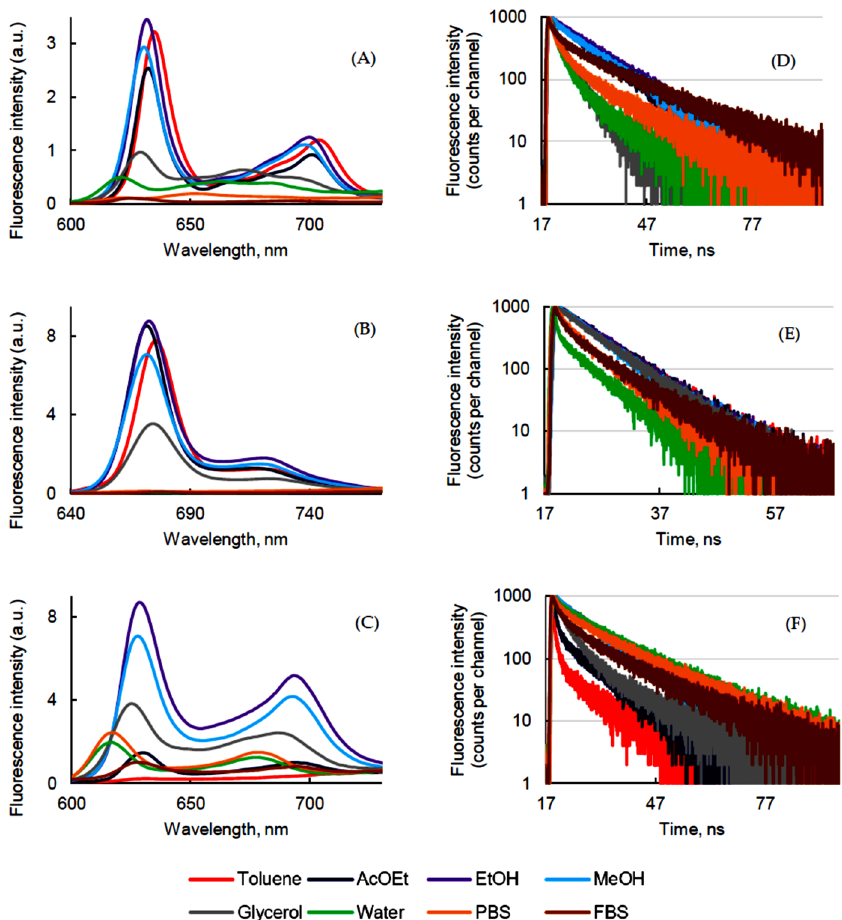
Figure 3. Fluorescence emission and decay ( λ exc = 408 nm) of PpIX ( A , D ), PPa ( B , E ), and PF ( C , F ) in different solvents (c = 1.87 μ M).